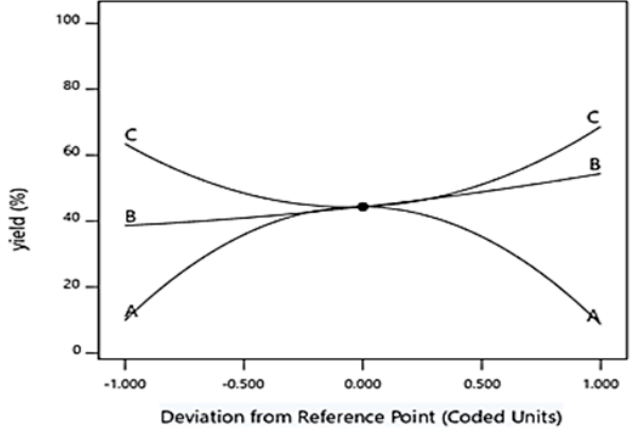
Figure 4. Effect of CC, RT, and MDAR (%).